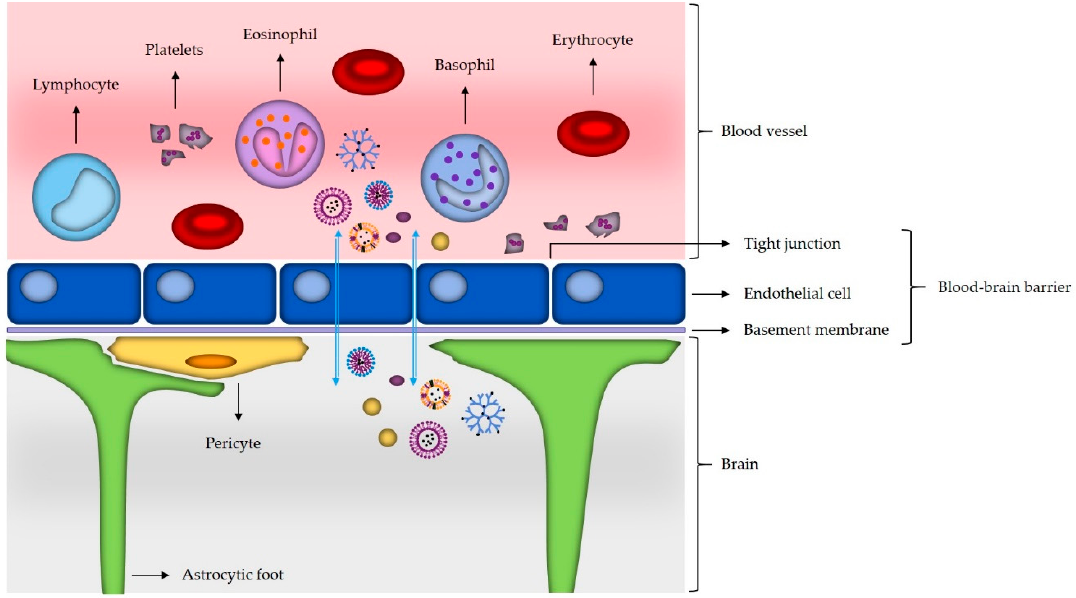
Figure 2. Schematic representation of the blood–brain barrier (BBB). Nanomaterials that are able to cross the BBB (gold nanoparticles, liposomes, micelles, dendrimers, exosomes and nanobodies) are illustrated. Blue arrows show transport through the BBB. The image is for graphical illustration only and does not represent actual sizes or size ratios among particles.